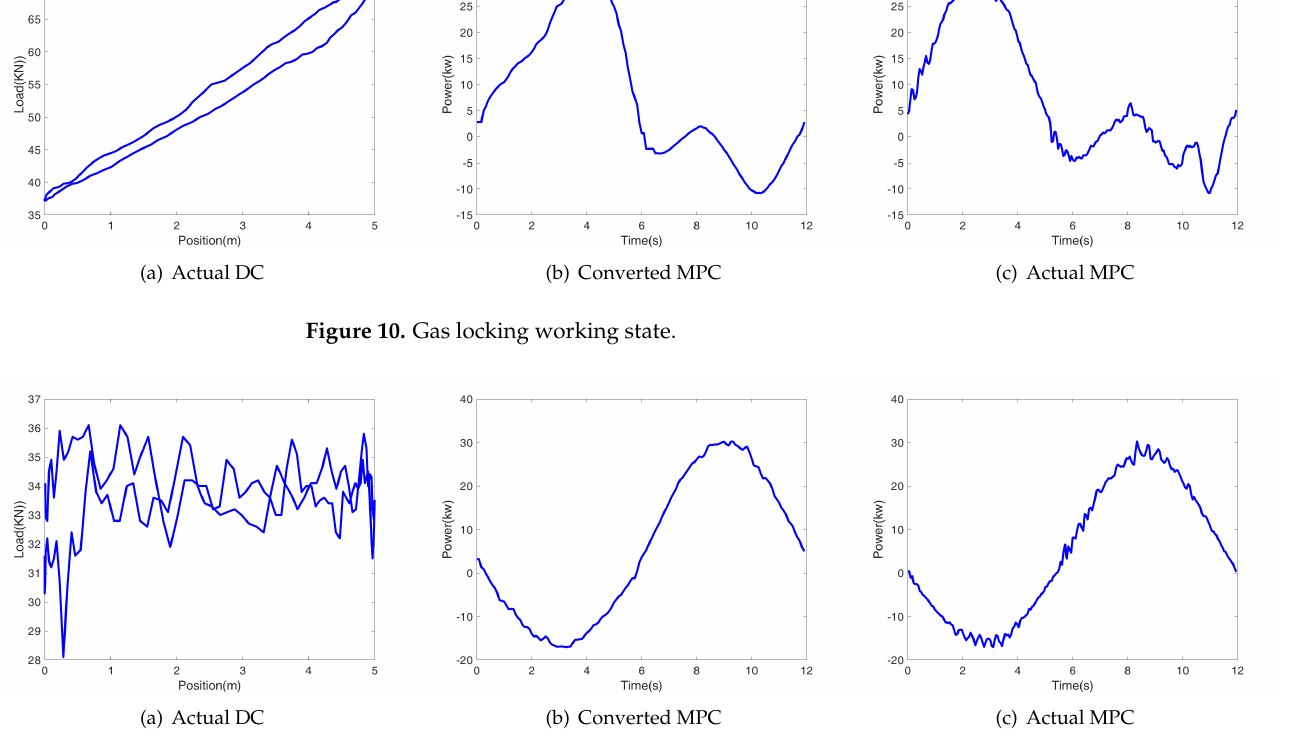
Figure 11. Parting rod working